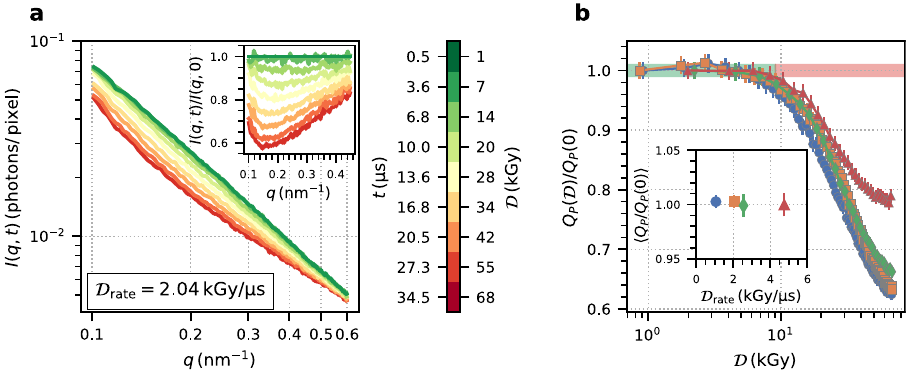
Fig. 2 | Static scattering signal of Ig-PEG. a The azimuthally integrated intensity, I ( q , t ), as a function of momentum transfer, q . The color indicates the absorbed dose D andthecorrespondingtimescales.Thedatashownareacquiredwithadose rate of 2.04kGy μ s − 1 . The inset displays I ( q , t ) normalized to the fi rst pulse I ( q ,0). b Porodinvariant, Q P ð D Þ ,calculatedfromthedatadisplayedin a (orange)andthree